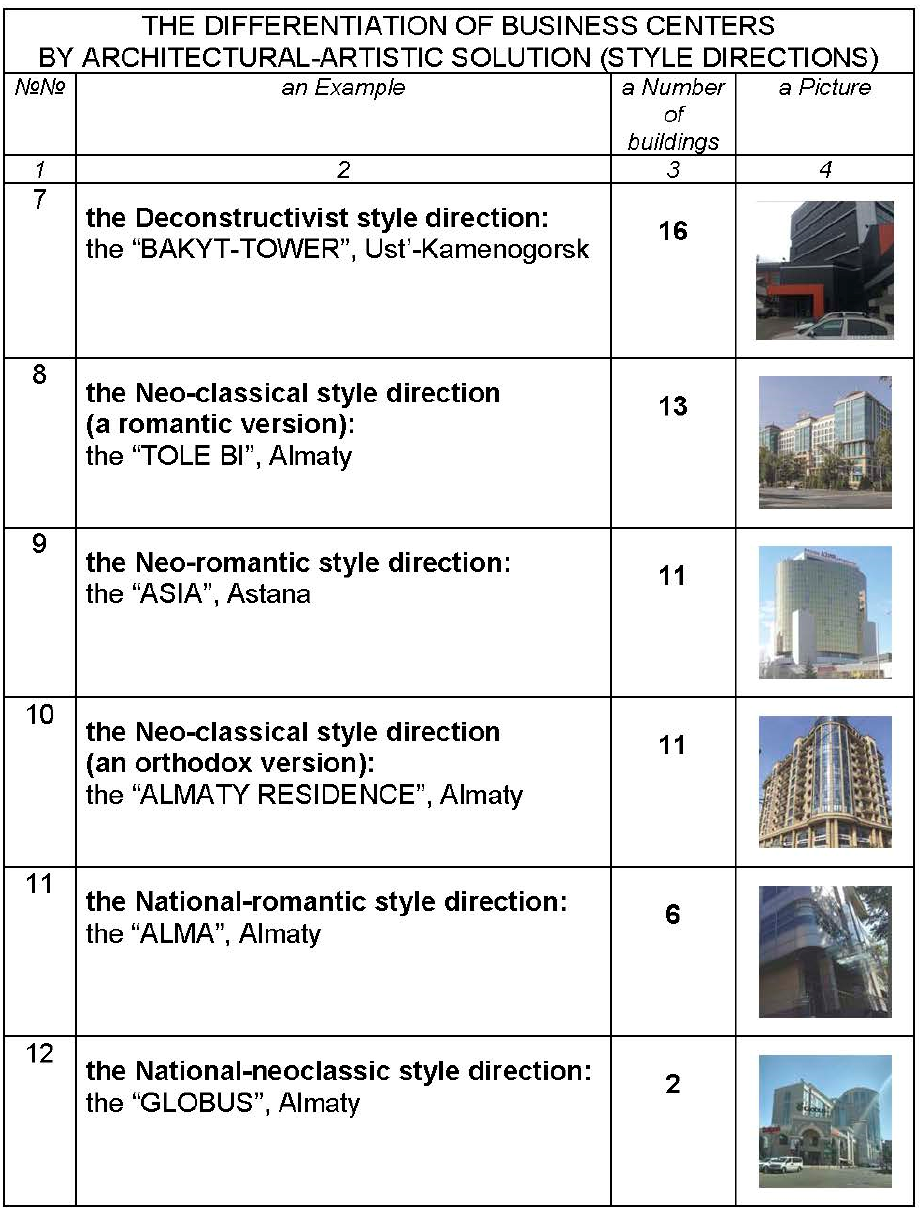
Figure 22. The differentiation of business centers by architectural-artistic solution (style directions): ( 7 ) the BAKYT-TOWER, Ust’-Kamenogorsk [153]; ( 8 ) the TOLE BI, Almaty [154]; ( 9 ) the AZIA, Astana [155]; ( 10 ) the ALMATY RESIDENCE, Almaty [99]; ( 11 ) the ALMA, Almaty [156]; and ( 12 ) the GLOBUS, Almaty [157].